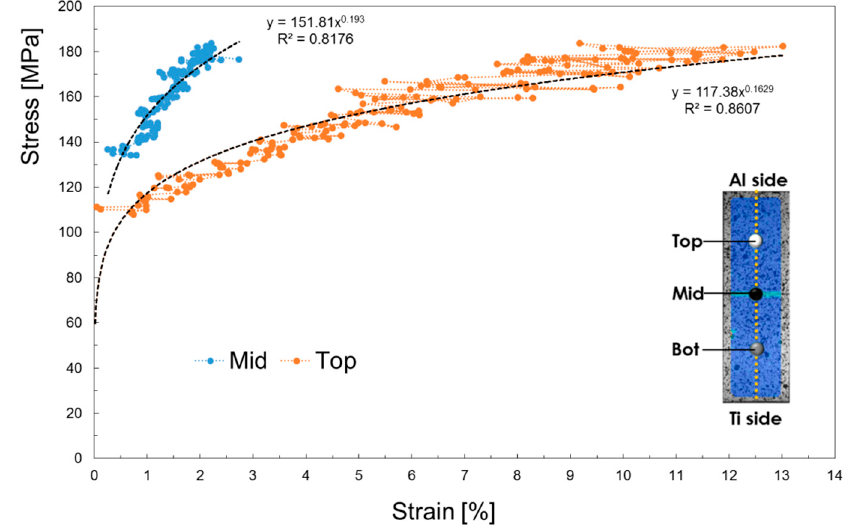
Figure 12. Local flow stress obtained from the test conducted on the sample welded setting the Off-set to 0.3 mm and the Focus to − 2 mm.